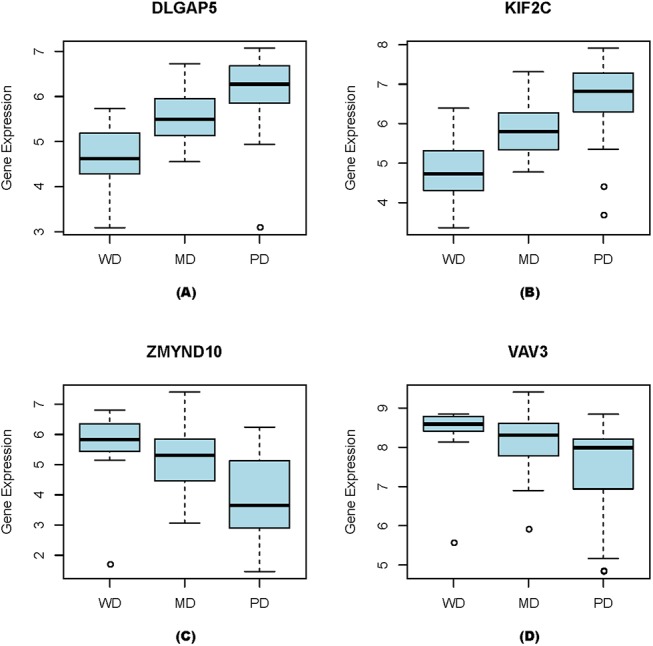
Correlation between gene-expression levels and three grades of breast cancer.(A) DLGAP5, (B) KIF2C, (C) ZMYND10, and (D) VAV3.